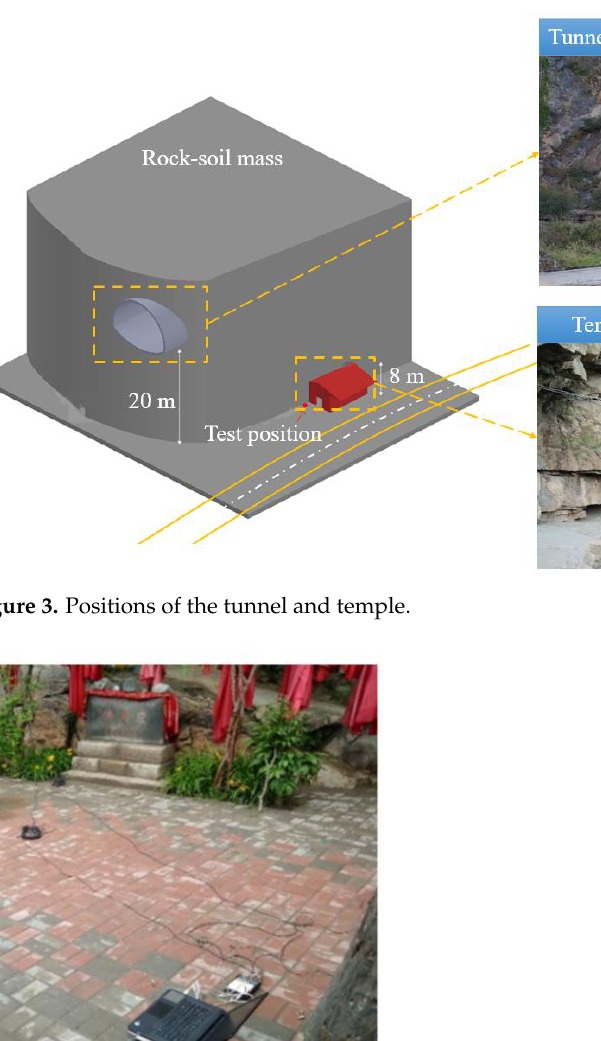
Figure 4. A measurement and monitoring point of PPV values induced by blasting.